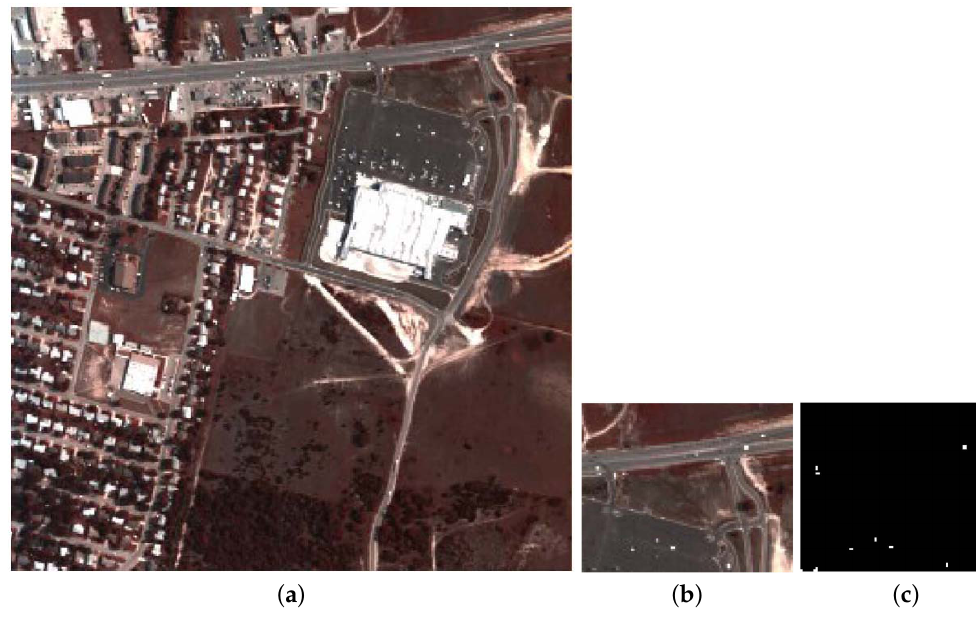
Figure 6. The first Hyperspectral Image (HSI1). ( a ) The false color image of the entire image; ( b ) The false color image of the chosen area for detection; ( c ) The ground-truth map of the chosen area